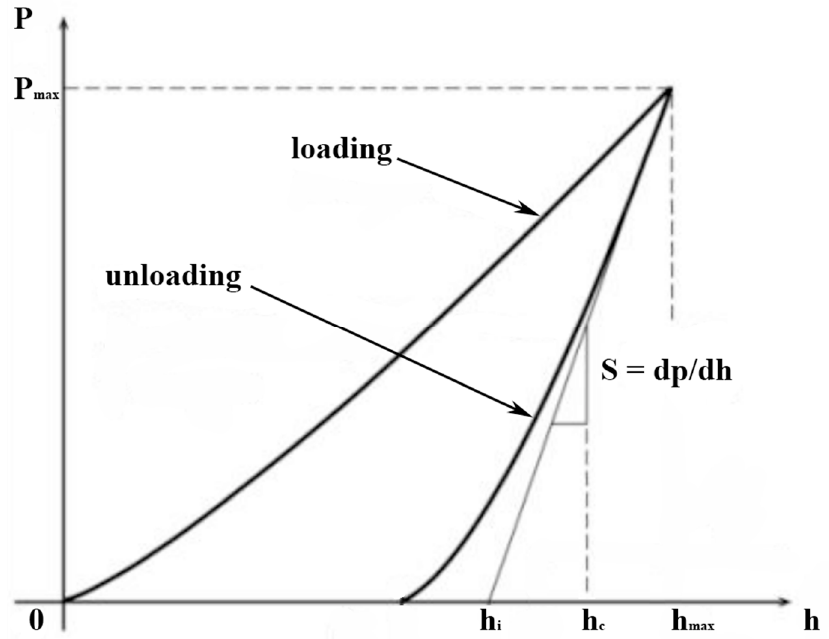
Figure 2. Scheme of loading–unloading curve.